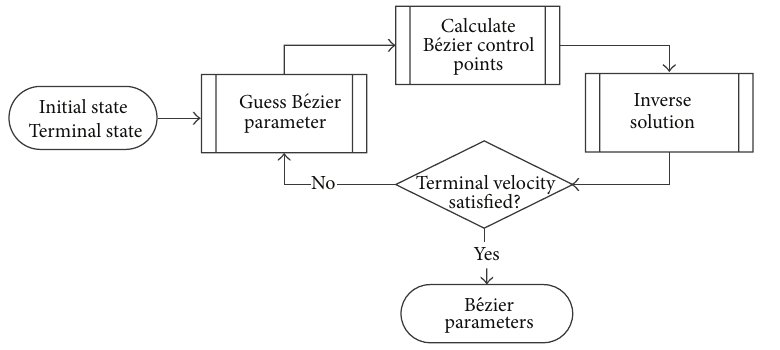
Figure 5: Off board parameter optimization process.